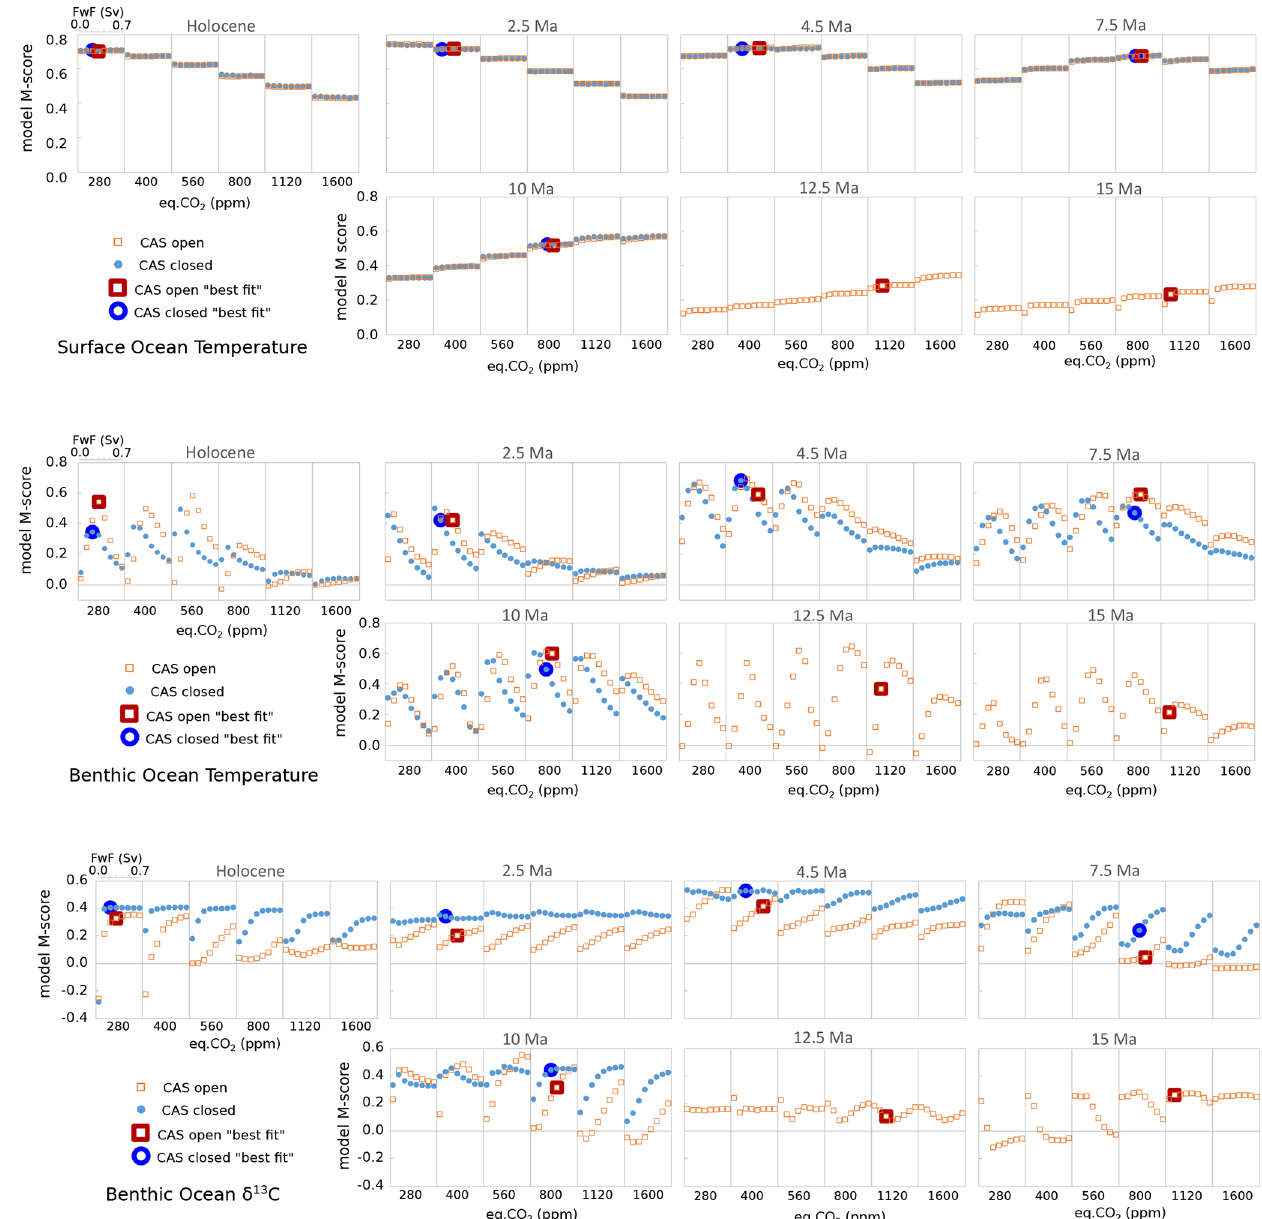
Figure 5. The M-score for the fit of the model to data for surface temperature, benthic temperature, and benthic δ 13 C. The model settings are plotted on the y axis (totalling 48 simulations per